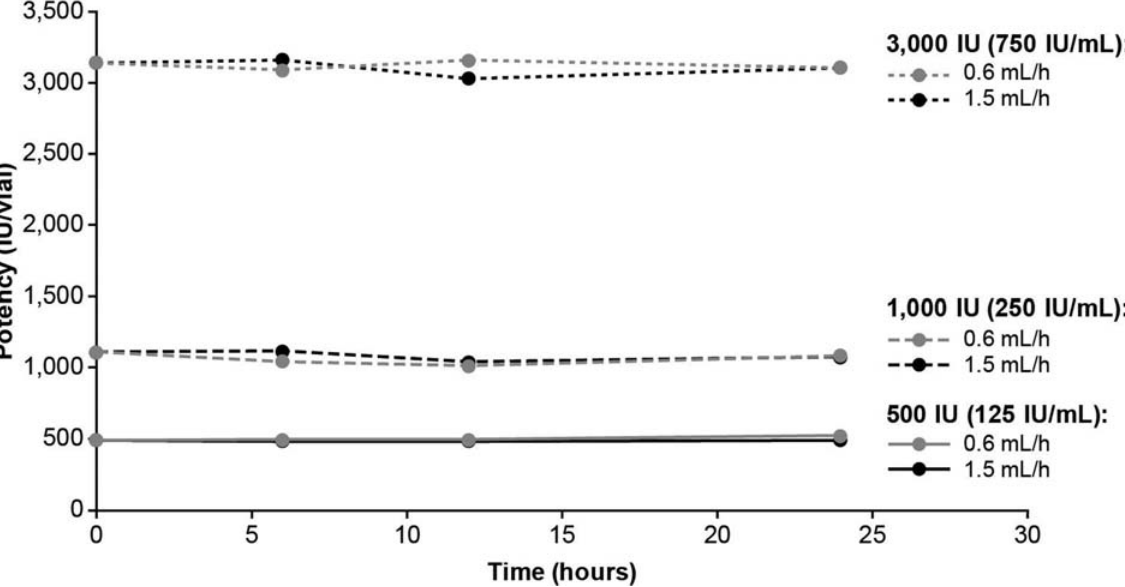
Fig. 1 Potencyofturoctocogalfaassessedduring24hoursofCIatpumpspeedsof0.6and1.5mL/h.Thefollowingturoctocogalfasampleswereassessed: 500 IU (equating to125IU/mL), 1,000 IU (equating to 250 IU/mL), and 3,000 IU (equating to750IU/mL). The potency results for the test samples wereall withintheprede fi nedacceptancecriteria(within20%ofthemeanpotencyofthesampleof t ¼ 0hours).For the1.5mL/hourpumpspeed,the%difference fromthemeanpotencyat t ¼ 0hourswas (cid:5) 1.57, (cid:5) 1.58,and – 0.16for500-IUsamples;0.71, (cid:5) 5.96,and (cid:5) 2.87for1,000-IUsamples;and0.69, (cid:5) 3.50,and (cid:5) 1.12 for 3,000-IU samples. For the 0.6mL/hour pump speed, the % difference from the mean potency at t ¼ 0hours was 0.42, 0.43, and 5.99 for 500-IU samples; (cid:5) 5.72, (cid:5) 8.49, and (cid:5) 2.15 for 1,000-IU samples; and (cid:5) 1.60, 0.63, and (cid:5) 1.11 for 3,000-IU samples. CI, continuous infusion.